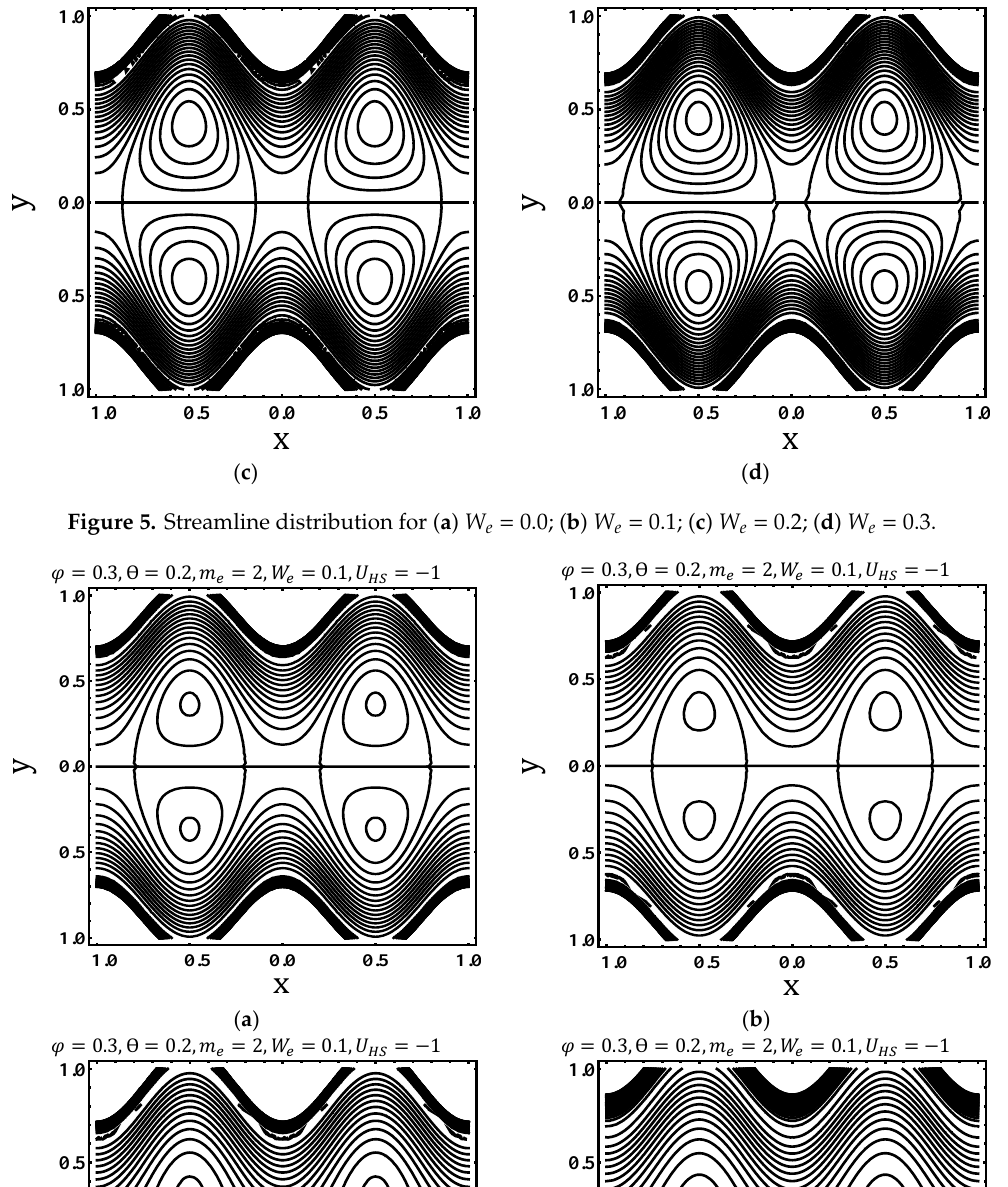
= 0.389; ( b ) n = 0.589; ( c ) n = 0.789; ( d ) n = i i i i